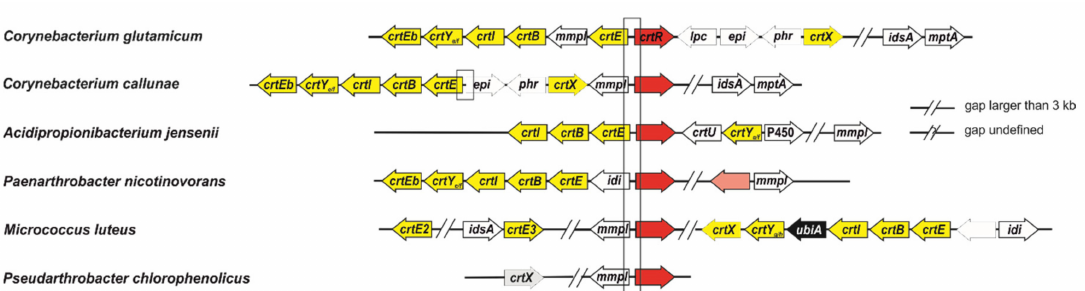
Figure 1. Genomic organization of crtR from C. glutamicum ATCC 13,032 and the crtR orthologs